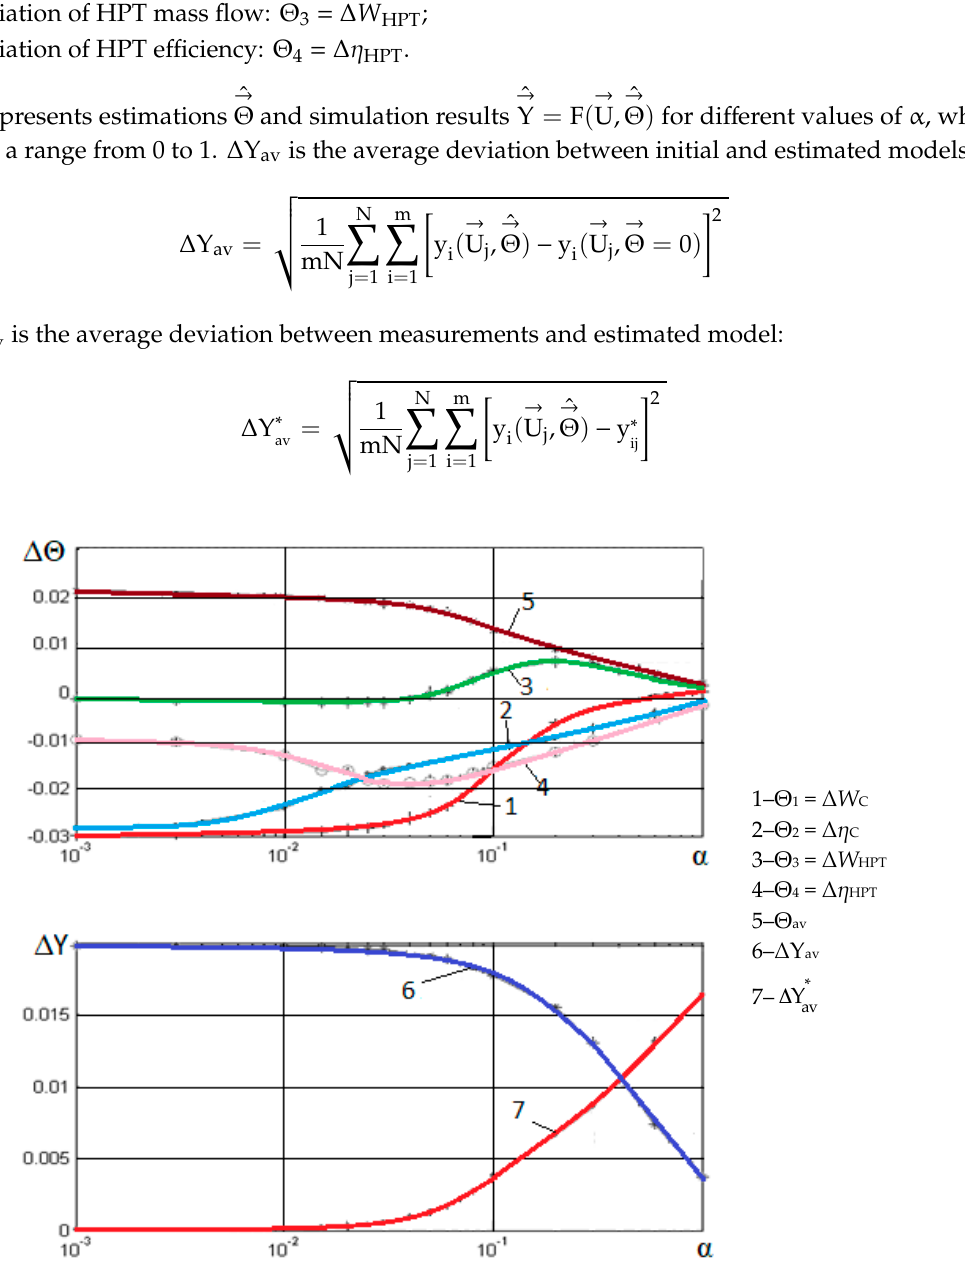
Figure 3. Influence of the regularization coefficient on estimations when noise is absent.